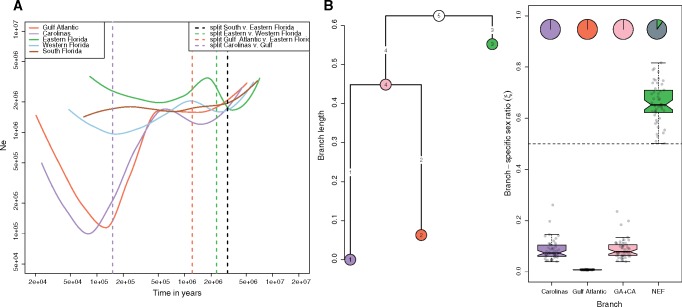
—Variation in effective population sizes with time and comparison of drift between autosomes and sex-linked scaffolds. (A) Reconstruction of past variations in effective population sizes (Ne) inferred by SMC++. Dashed vertical lines correspond to the estimated splitting times between the five genetic clusters previously inferred. We assume a mutation rate of 2.1×10−10/bp per generation and a generation time of 1 year. (B) Average branch lengths obtained from autosomal data and ESRs (ξ) inferred from KIMTREE. A set of 5,000 autosomal and 5,000 sex-linked markers were randomly sampled to create 50 pseudoreplicated data sets on which the analysis was run. The analysis was run on the three most closely related populations. Pie charts indicate the proportion of replicates for which we observed significant support (Si<0.01) in favor of a biased sex-ratio.